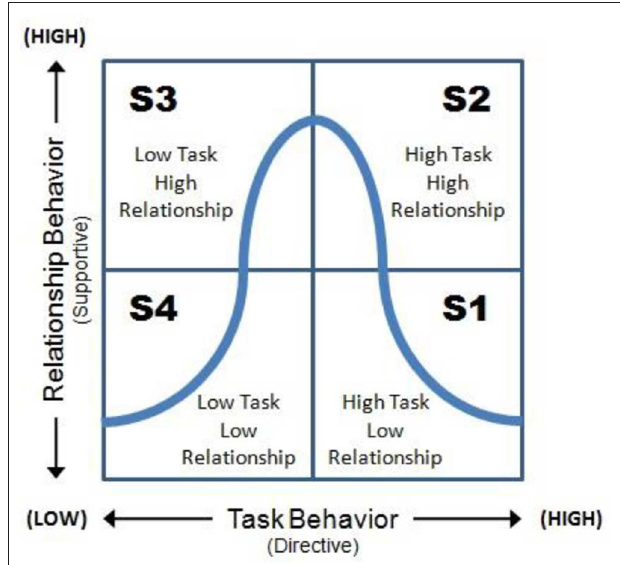
FIGURE 1 | The life-cycle theory of leadership. The quadrants represent degrees of the dimensions, “task,” and “relationships.” Later, four leadership styles were mentioned: S1: directing, S2: coaching, S3: supporting, S4: delegating (Blanchard et al.,